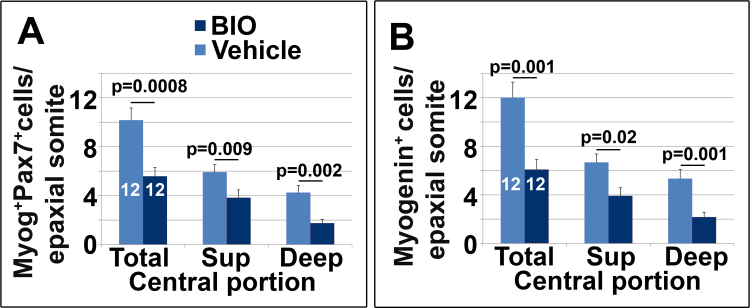
Reduction of MPC differentiation by BIO. The pax7a:GFP BAC transgene was bred onto a pfe/pfe background to diminish xanthophores and larvae at 3 dpf treated with BIO or vehicle were stained in wholemount at 4 dpf for GFP, Myog and DNA. The number of pax7a:GFP+Myog+ (A) and Myog+ (B) cells in the epaxial central portion of somites 16–18 of 12 BIO-treated embryos compared with 12 controls. Data are from the same experiment as shown in Fig. 8B. Sup = superficial.